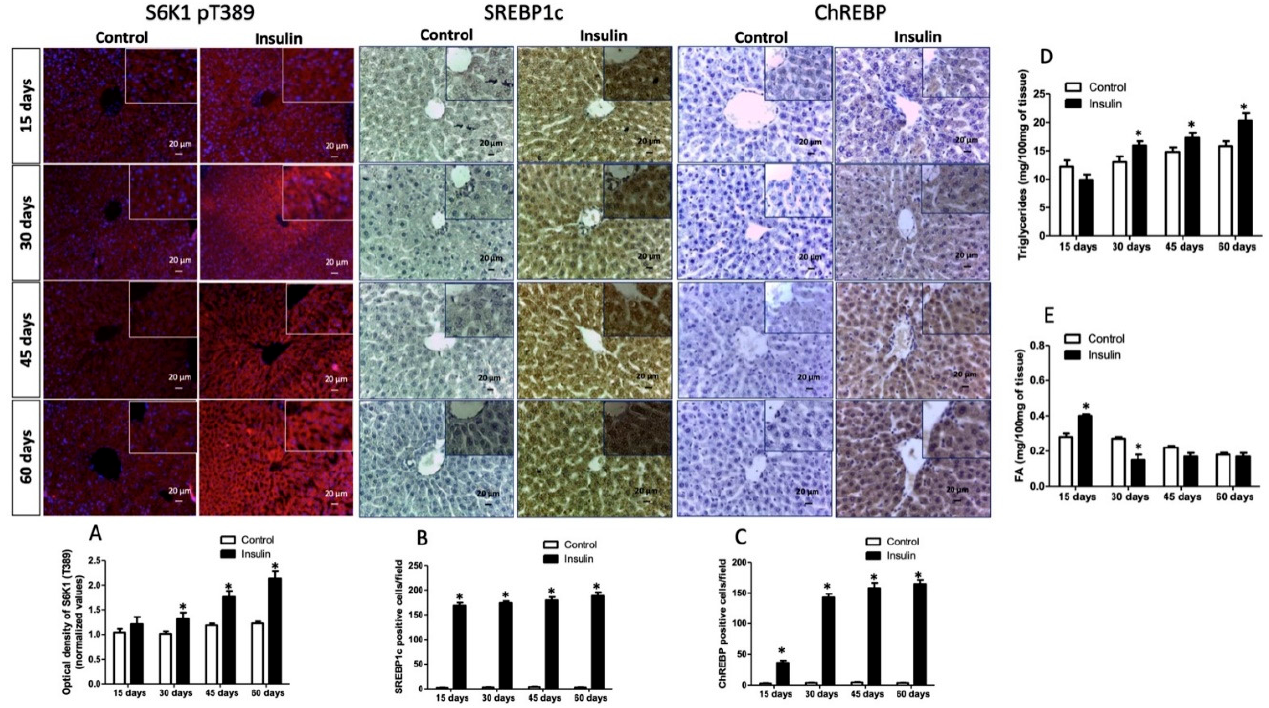
Figure 4. De novo lipogenesis pathway analysis. ( A ) Threonine phosphorylation of S6K1 (T389); ( B ) number of immunoreactive cells for SREBP1c; ( C ) number of immunoreactive cells for ChREBP; ( D ) hepatic triglyceride concentration; ( E ) hepatic fatty acid concentration. Results are the mean average of 10 separate experimental animals per group ± SEM. (*) indicates a significant difference compared to the control groups ( p ≤ 0.05). Figures ( A – C ) were analyzed by Mann–Whitney U test, and ( D , E ) figures were analyzed by the Student’s t -test. The scale bar corresponds to 20 µ m in a magnification of 400 ×